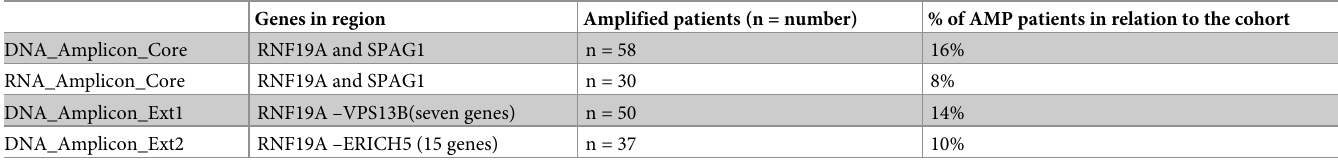
Table 1. Core and extended 8q22.2 amplicons.